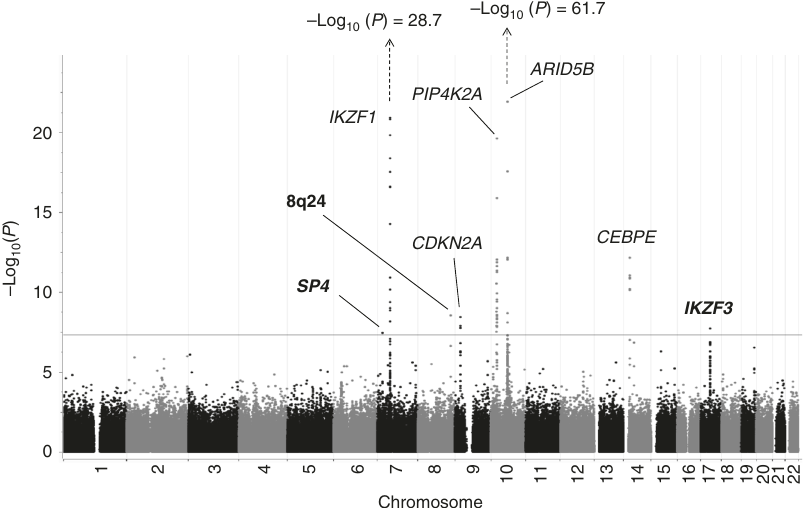
Fig. 1 Manhattan plot of P values resulting from meta-analysis of three separate analyses in the California population (Latinos, non-Latino whites, and non- Latino blacks) including study-speci fi c controls and GERA controls (total N = 3263 cases, 15,977 controls). The locations of prior identi fi ed GWAS hits are indicated by their gene acronyms. New genetic associations identi fi ed in this study are highlighted in bold. These association peaks exceed the Bonferroni genome-wide P value cutoff of 5 × 10 − 8 indicated by a horizontal